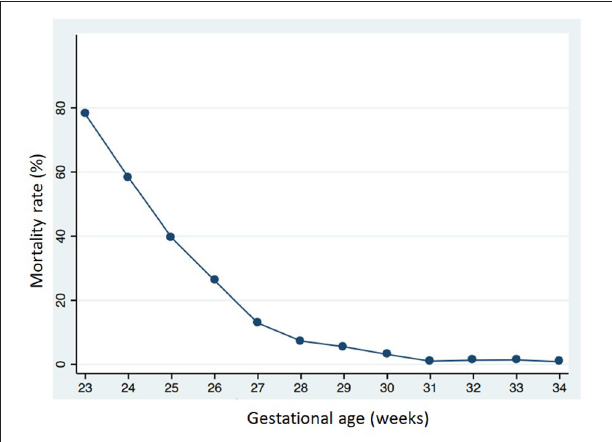
FIGURE 1 | Mortality rate in relation to gestational age at